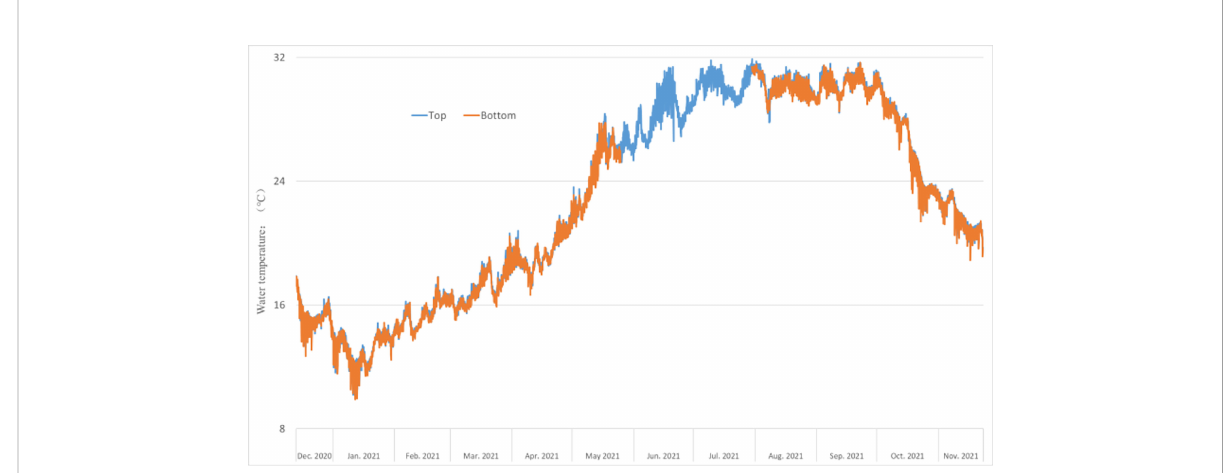
FIGURE 4 Trend chart of monthly average water temperature change from December 2020 to November 2021.